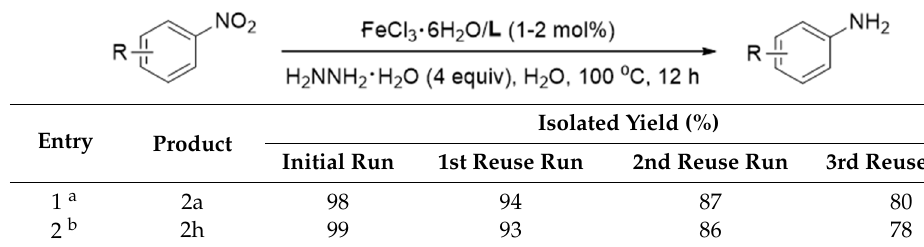
Table 4. Reuse studies of the Fe ‒ catalyzed reduction of nitroarenes.